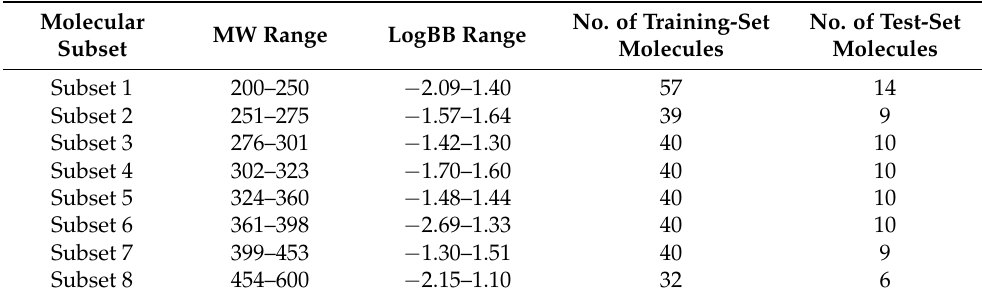
Table 1. Characteristics of the eight molecular subsets prepared to derive and validate 3D-QSAR model for LogBB